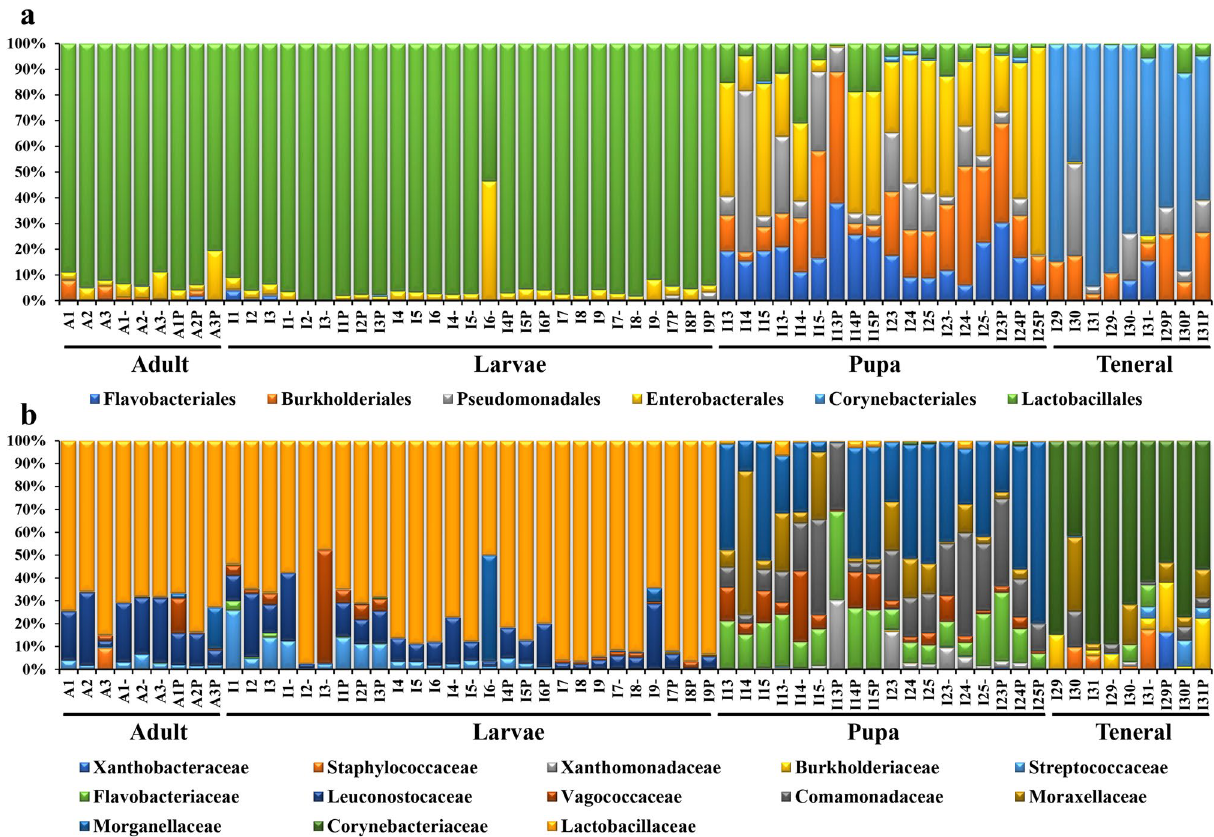
Figure 3. Bacterial diversity composition of Lucilia sericata life stages: ( a ) Order; (b) Family (sample symbols, except control: “–” specimens fed with 10 2 S. enterica concentration; “P” specimens fed with 10 4 S. enterica